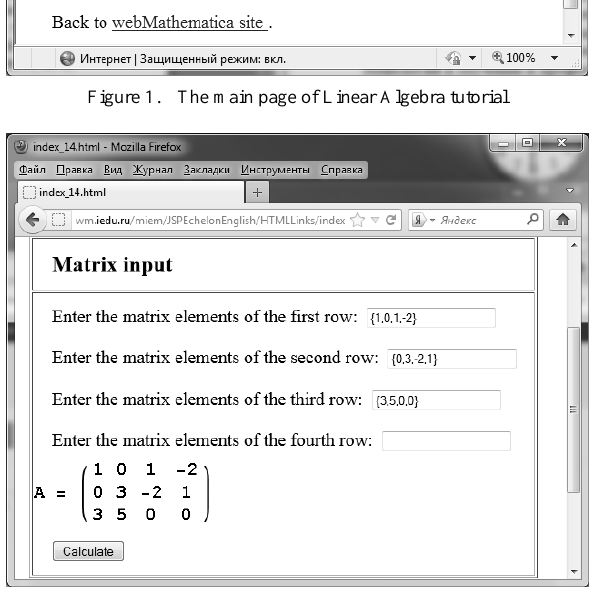
Figure 2. HTML-formcalled Matrix input